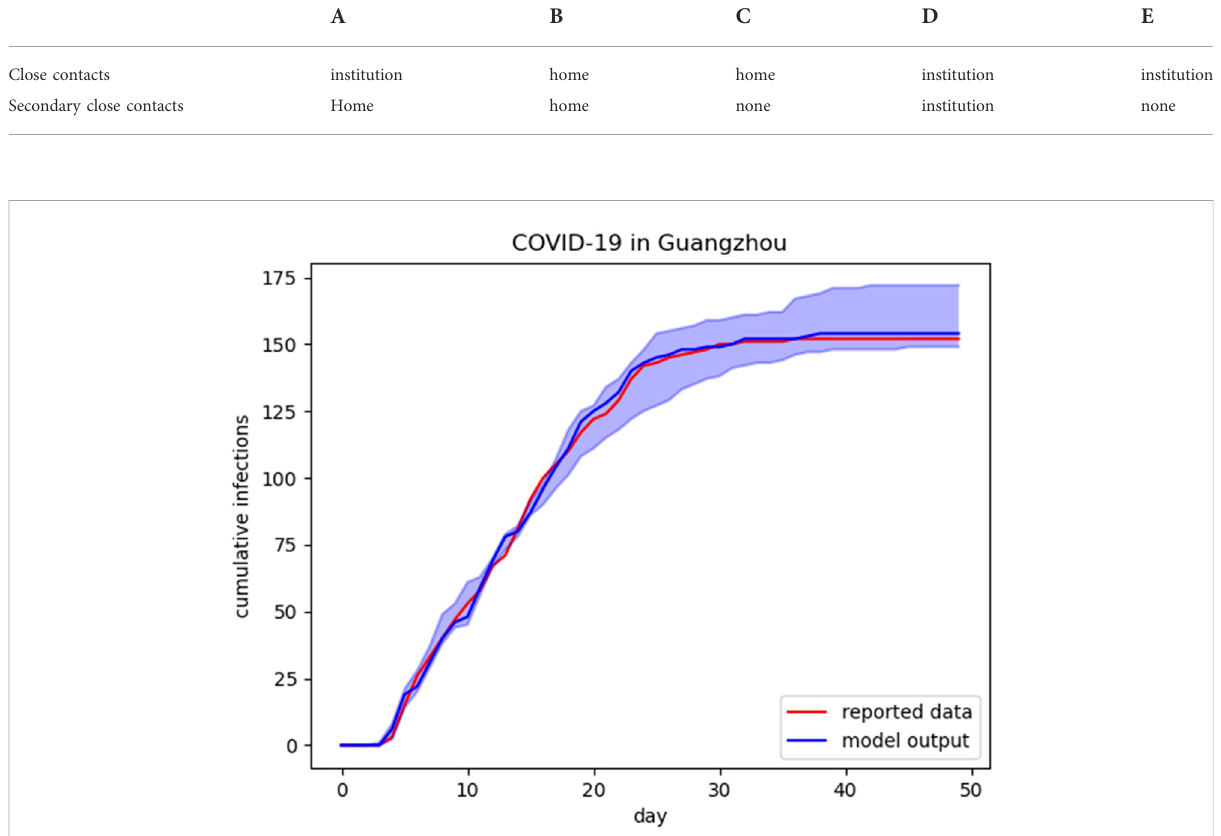
FIGURE 3 Calibration.Bluecurveillustratesthepredictionsfromthemodelandredcurveisactualcumulativeinfectionsdata.Theblueshadingrepresents the 95% CI for the simulation